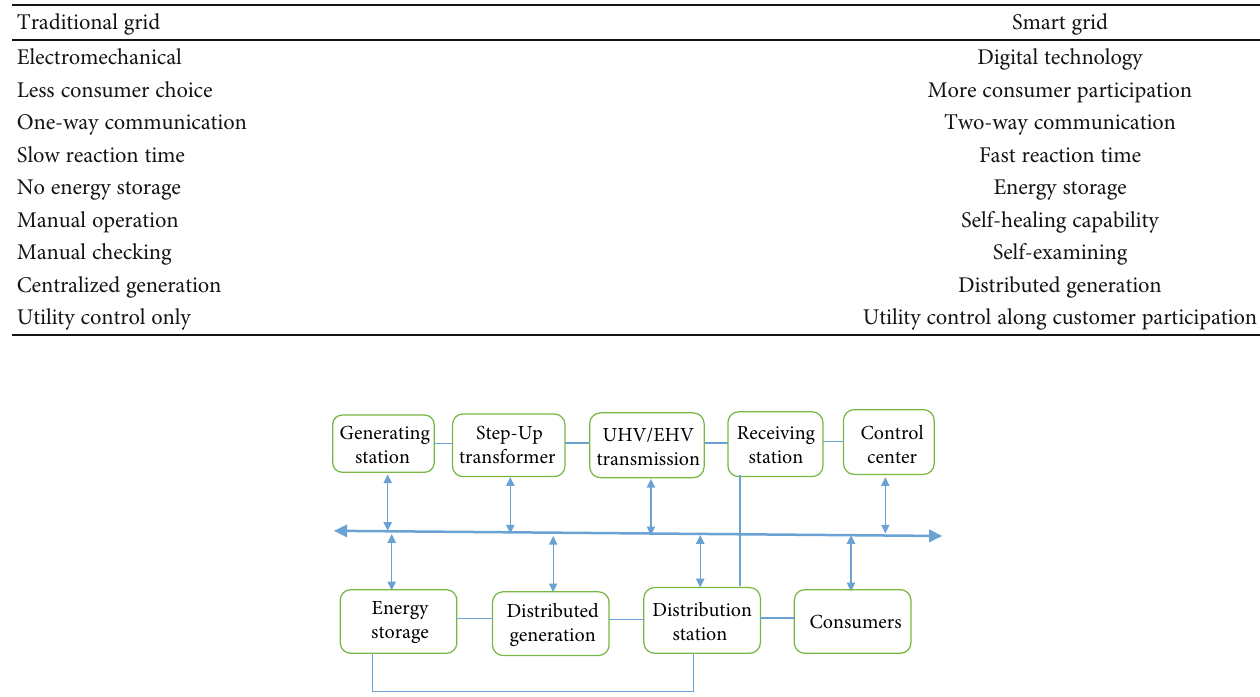
Table 4: Comparison between traditional grid and smart grid.